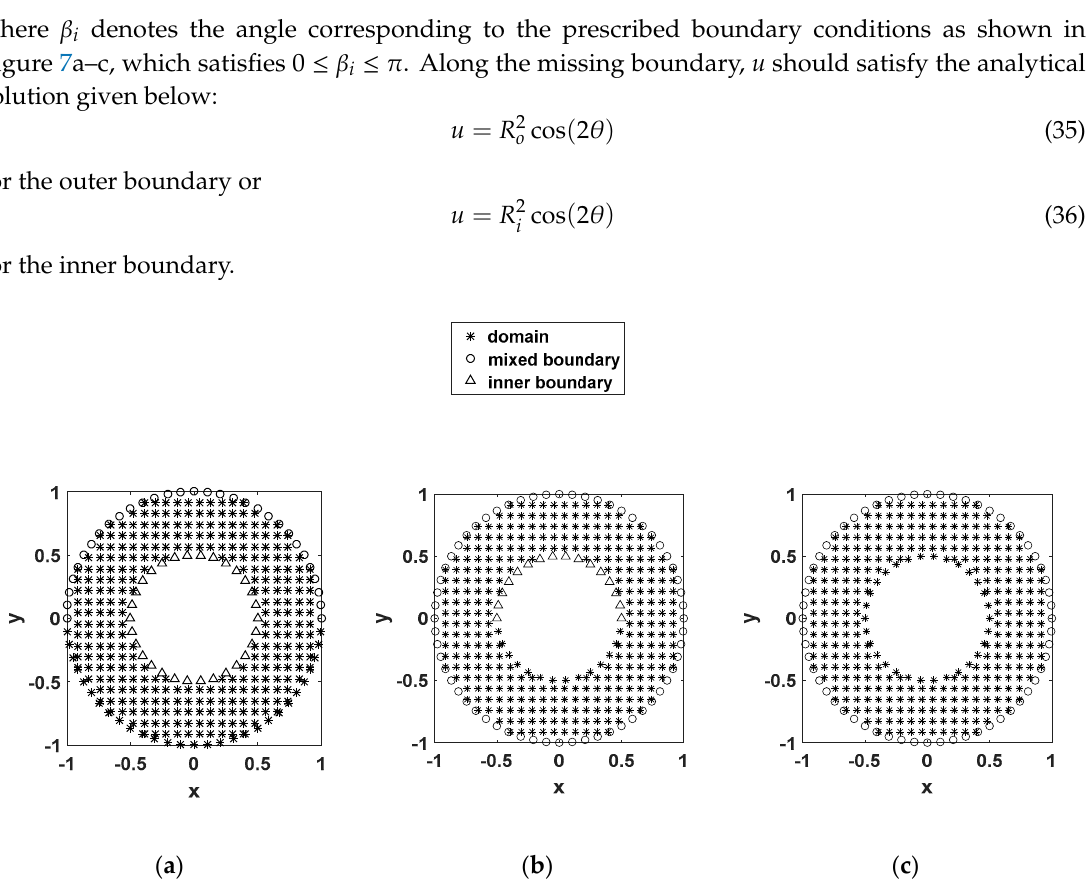
Figure 7. Discretization of annular domains: ( a ) half unknown outer boundary; ( b ) half unknown inner boundary; ( c ) unknown inner boundary.